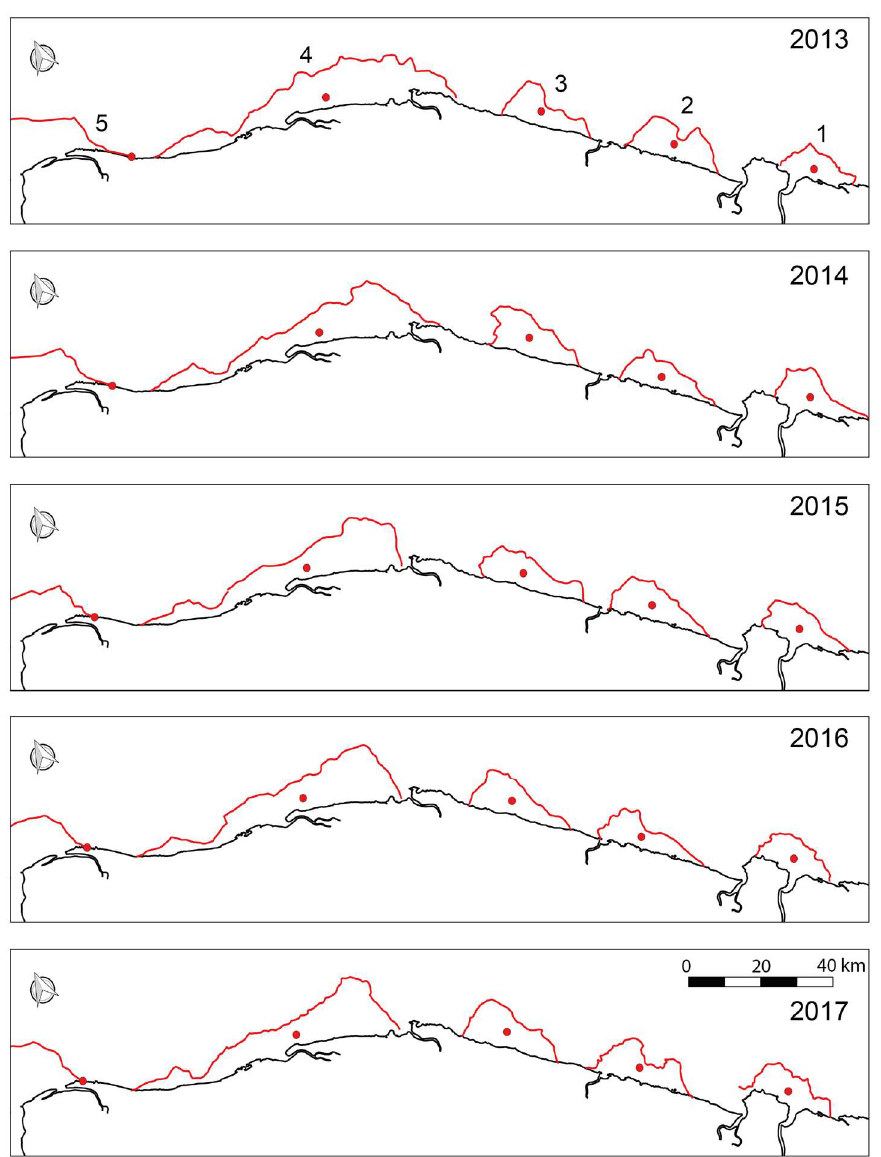
Figure 5. Location and migration of existing mud banks on the French Guianese coastal between the dry seasons of 2013 and 2017. The red line corresponds to the footprint delimitation using the SPM values method, and the red circle corresponds to the barycentre of each mud bank for each year.